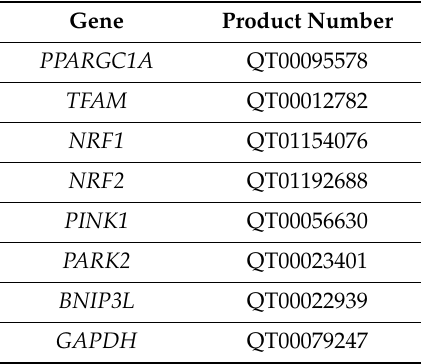
Table 1. List of primers used to amplify the transcripts of the indicated genes by q-RT-PCR. Gene